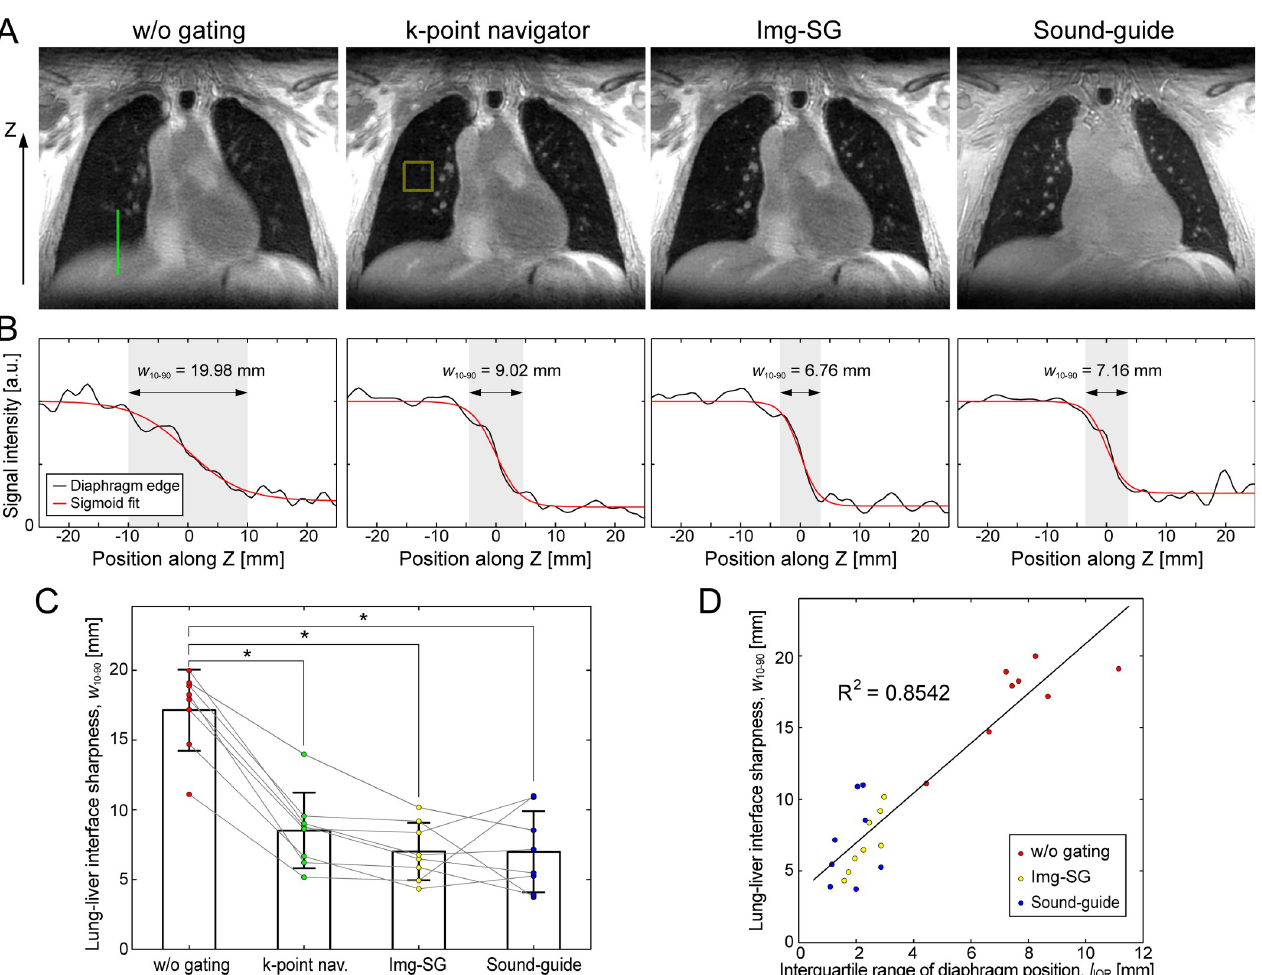
Fig 5. Sharpness of the lung-liver interface for high-resolution UTE MR images. A) Images from k-point navigator, image-based self-gating (Img-SG) and sound-guided respiration (Sound-guide) show visually clear improvement in the lung-liver interface as compared to free-breathing without gating (w/o gating). B) The sharpness of the lung-liver interface was quantified by fitting the intensity profile at the top flat region in the right hemidiaphragm (green line in A) with a sigmoid function. C) Reduction of the 10–90% rise distance, w 10-90 , with k-point navigator (8.51 ± 2.71 mm), Img-SG (7.01 ± 2.06 mm) and Sound- guide (6.99 ± 2.90 mm) relative to w/o gating (17.13 ± 2.91 mm) was statistically significant ( p < 0.0001 for all of k-point navigator, Img-SG and Sound-guide). w 10-90 for Img-SG and Sound-guide was narrower than k-point navigator, but not statistically significant ( p = 0.017 and 0.31 for Img-SG and Sound-guide, respectively). D) The sharpness of the lung-liver interface in the high-resolution images was linearly correlated with interquartile range of the diaphragm position l IQR shown in Fig 4C (R 2 = 0.8542). Colored points represent the values for individual subjects ( N = 8). � represents p < 0.05/6 = 0.0083 in C with the Bonferroni adjustment for multiple comparison. The data shown in A and B are from the same subject as the one in Figs 2–4. ( p = 0.0007) and Img-SG ( p = 0.0006) due to an increase of the blood inflow effects. The differ- ence between k-point navigator and Img-SG was not significant ( p = 0.94).